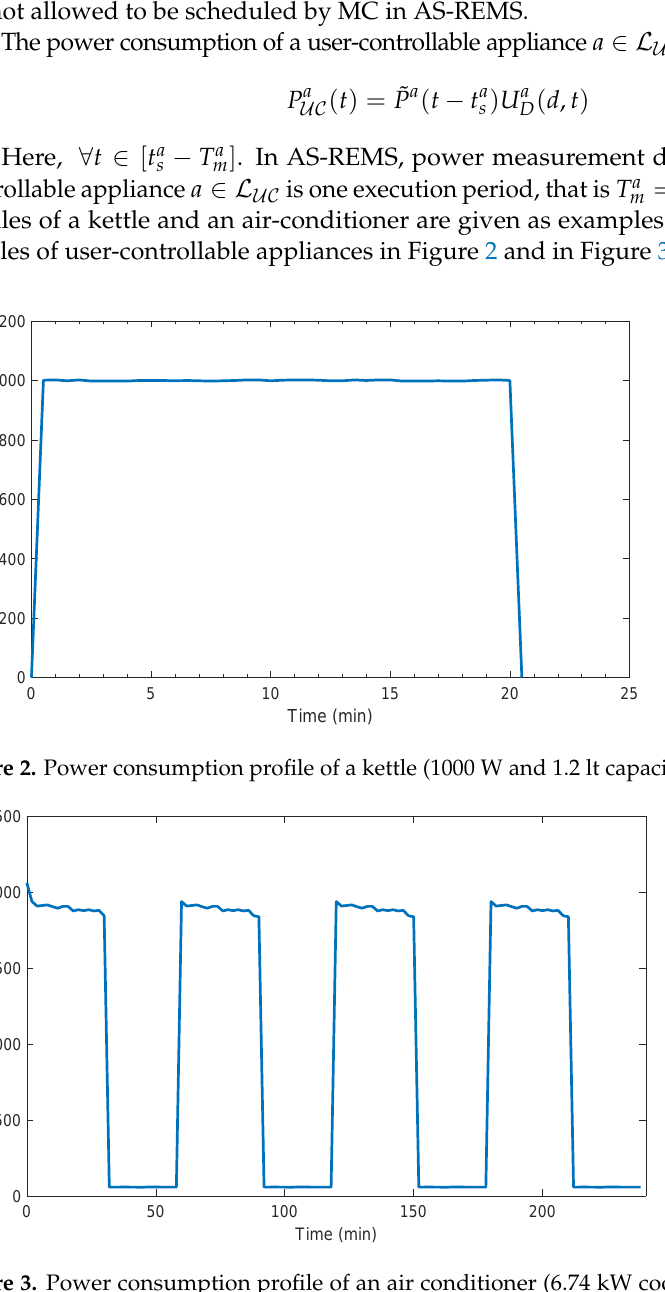
Figure 3. Power consumption profile of an air conditioner (6.74 kW cooling and 7.03 kW heating